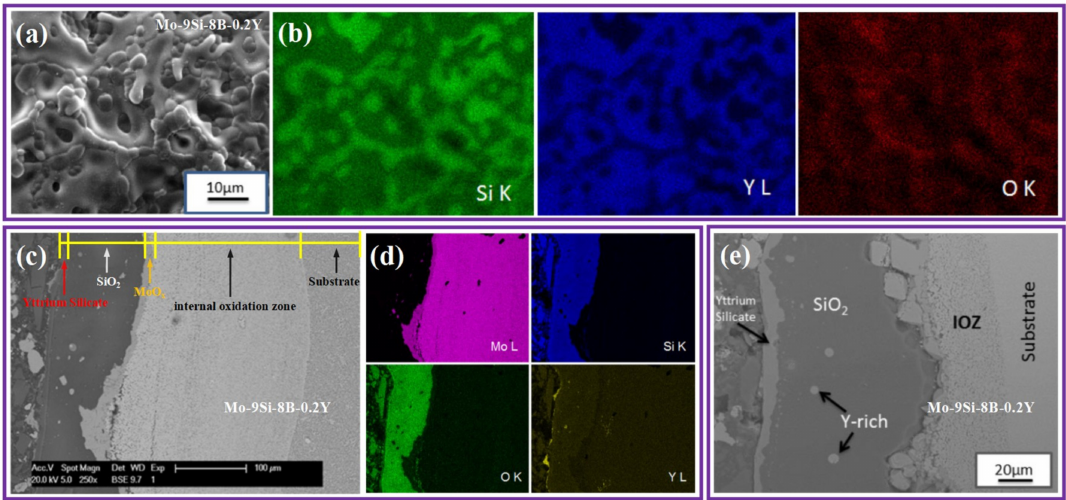
Figure 10. Surface SE ( a ) and cross-sectional BSE ( c , e ) images of 0.2 at.% Y-doped samples oxidized at different conditions: 1300 ◦ C for 100 h ( a , c ) and 1400 ◦ C for 2 h ( e ); ( b , d ) are the element mappings of ( a , c ), respectively. Reproduced with permission [123]. Copyright 2013 Springer